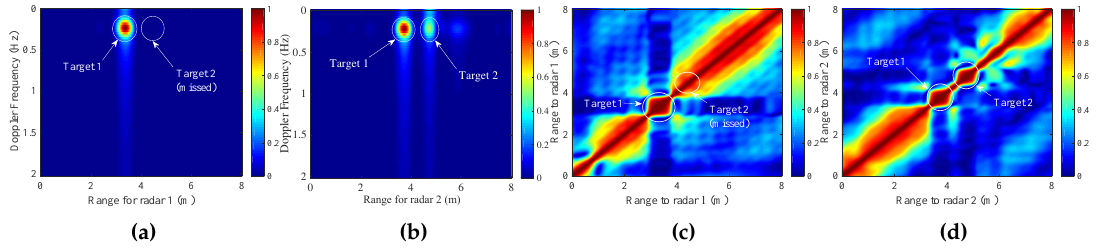
Figure 10. Comparison results of Experiment 1.2: ( a ) RD plane of Figure 9e; ( b ) RD plane of Figure 9f; ( c ) single-radar correlation result of Figure 9e; and ( d ) single-radar correlation result of Figure 9f.